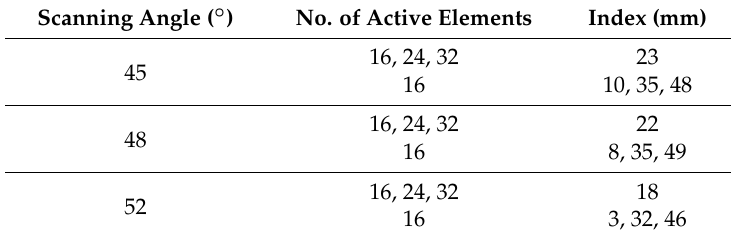
Table 5. Number of active elements, scanning angles and indexes of the CIVA simulation.